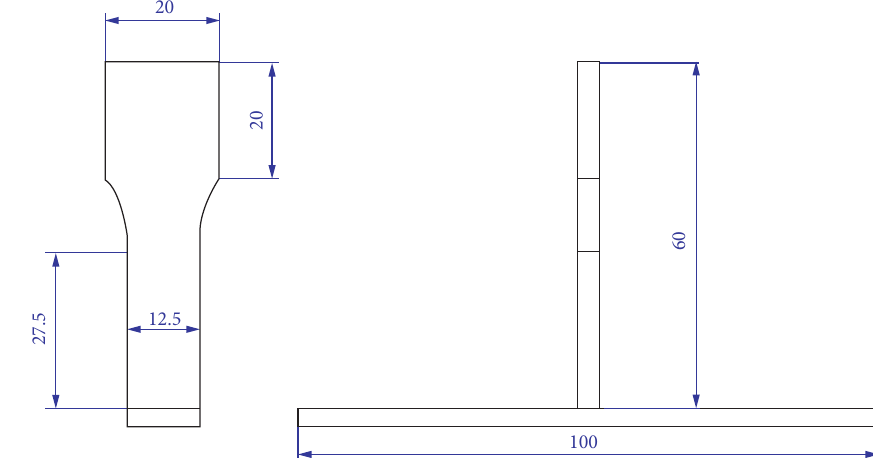
Figure 4: Dimensions of tensile samples along the stringer (in